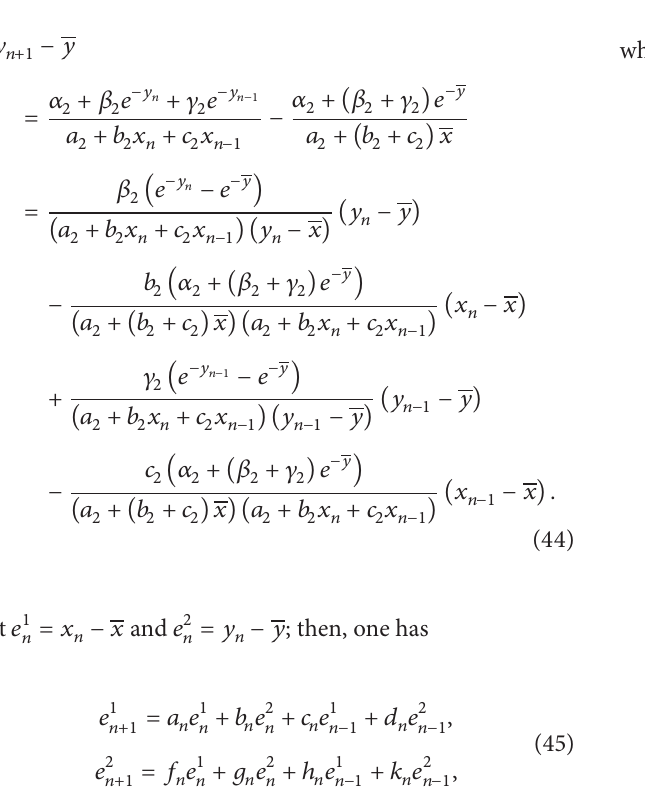
Figure 1: Plots for the system